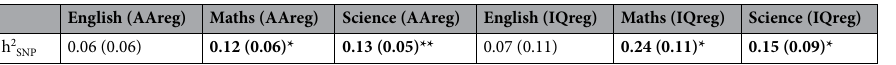
Table 4. SNP-based heritability (h 2 SNP ) estimates for academic subjects after controlling for attainment in other subjects (AAreg), and after controlling for IQ (IQreg). SNP-based heritabilities were estimated using LD score regression with h 2 intercepts constrained to 1. Bolded estimates show those that are significantly greater than 0, *p < 0.05, ** p < 0.01. Standard errors are in parentheses.